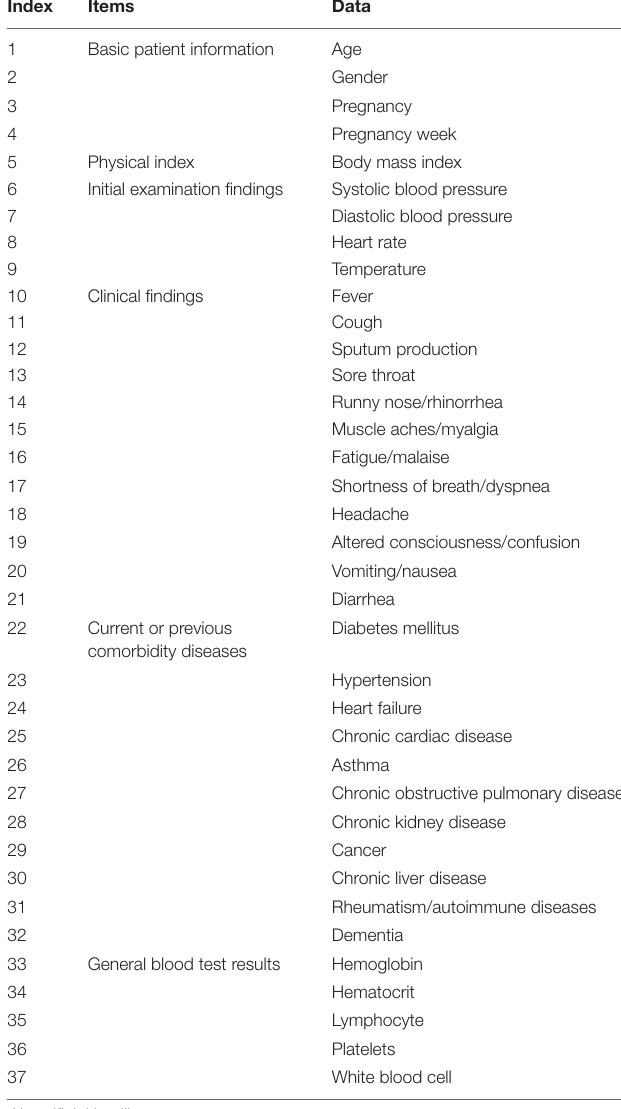
TABLE 1 | Medical records used in developing AI model for severity prediction.